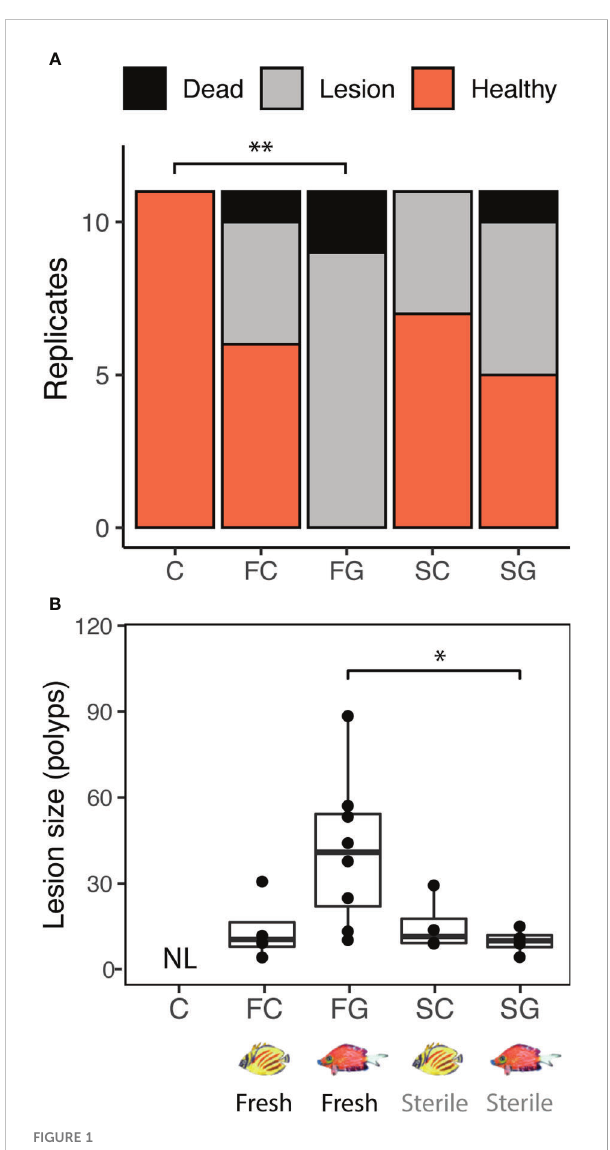
FIGURE 1 Fish species identity (corallivore or grazer/detritivore) in fl uenced the effect of feces on coral tissue integrity (A) and lesion size (B) . (A) Fresh grazer/detritivore feces caused lesions or mortality in all replicates (N = 11/11), whereas fresh corallivore feces only caused lesions or mortality in 45% of replicates (N = 5/11). Sterilized feces similarly caused lesions in 36% (N = 4/11; sterile corallivore feces) to 55% (N = 6/11; sterile grazer feces) of replicates (overall ordinal regression results: treatment c 2 = 32.3, p < 0.001; colony c 2 = 6.6, p = 0.761; **C-FG comparison: estimate = 2.97, p = 0.006). (B) Fresh grazer feces application caused lesions that were, on average, 4.2 times larger than sterile grazer feces (LM results: Treatment x2 = 13.49, Df = 3, p = 0.004; *pairwise comparison FG-SG: estimate = 1.33; adjusted p = 0.049, see Table S2 for individual comparisons). Together, these fi ndings show that grazer feces are more likely to be biologically harmful to corals within 22h of contact than are corallivore feces. “ NL ” : No lesions